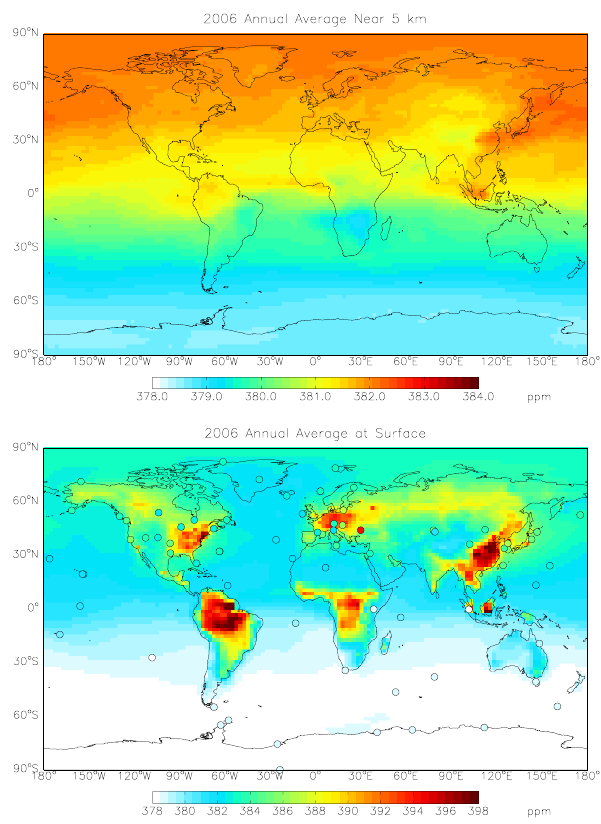
Fig. 11. Annually-averaged 2006 model CO 2 from a run with emissions from shipping, aviation and the chemical source. The upper panel shows CO 2 at the model level near 5km and the lower panel shows model CO 2 at the surface level compared with 74 GLOBALVIEW-CO 2 stations on the same color scale (colored